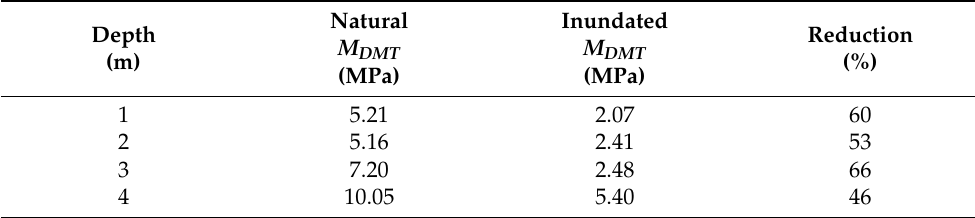
Table 3. M DMT values for the natural and inundated condition and the reduction observed on this parameter.